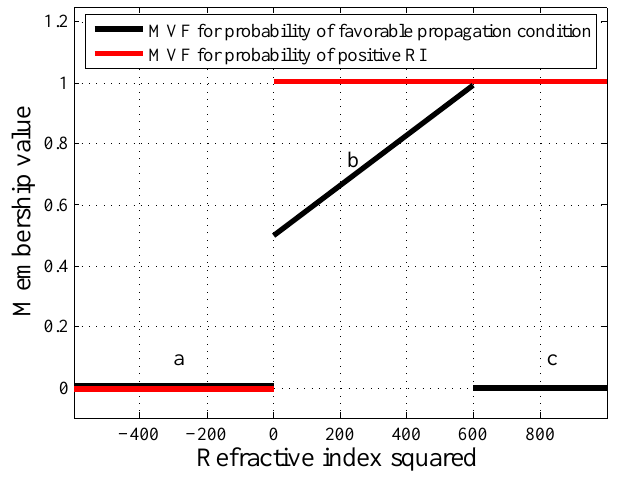
Figure 7. MVF used in the calculation of favorable propagation condition of Rossby waves (black curve). Red lines show MVF for calculating probability of positive vertical wave number which are used by Li et al. (2007). In their study the effect of the critical layer (part c) is not considered.